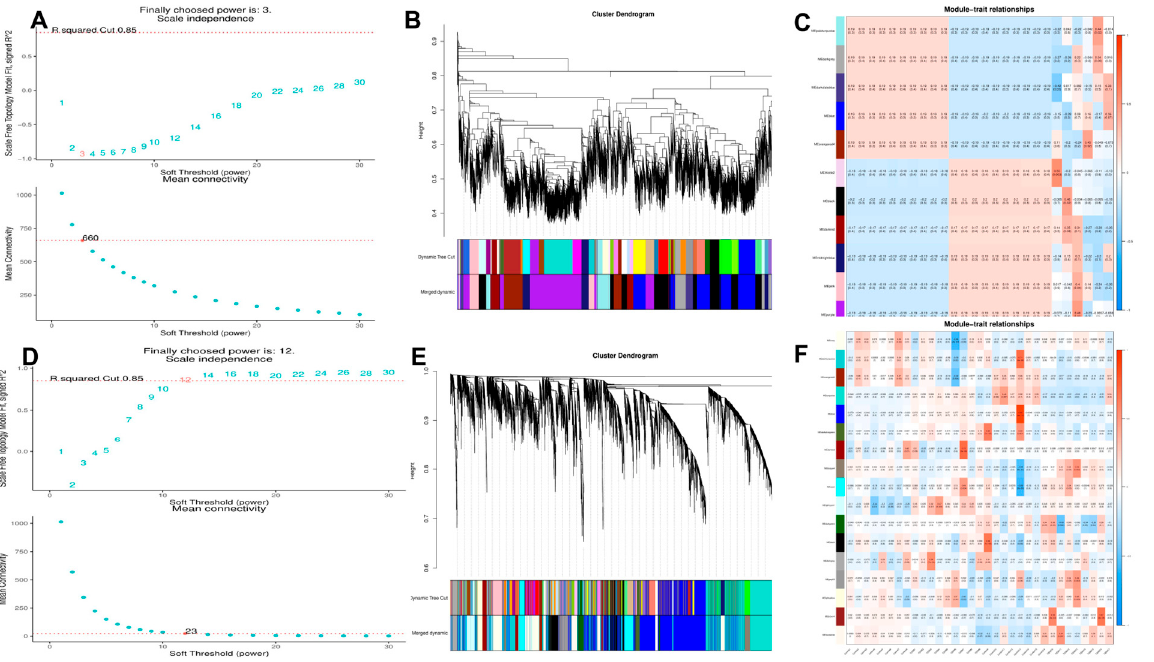
Figure 3. WGCNA for ( A ) the scale-free index for various soft-threshold powers, and ( β ) the mean con- nectivity for various soft-threshold powers for MCI. ( B ) Phyloclustering tree map of the genes for MCI. ( C ) Heatmap of module and trait/grouping correlation for MCI. ( D ) The scale-free index for various soft-threshold powers ( β ) and the mean connectivity for various soft-threshold powers for T2DM. ( E ) Phyloclustering tree map of the genes for T2DM. ( F ) Heatmap of module and trait/grouping corre- lation for T2DM.